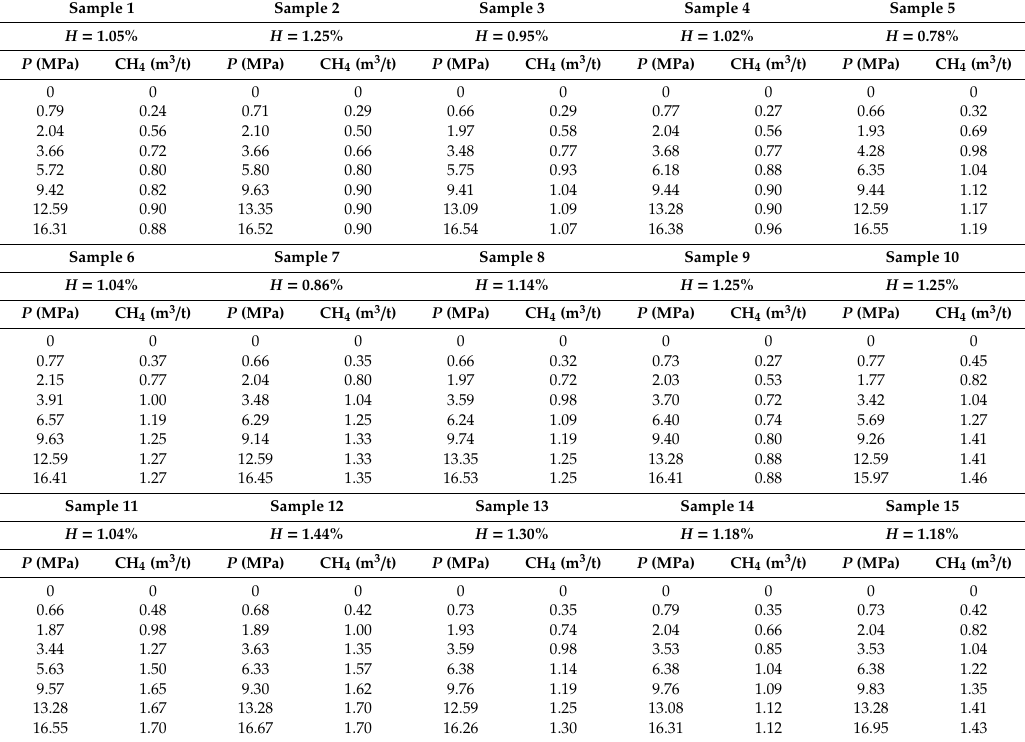
Table 1. Methane isothermal adsorption experimental result of 15 shale samples. Sample 1 Sample 2 Sample 3 Sample